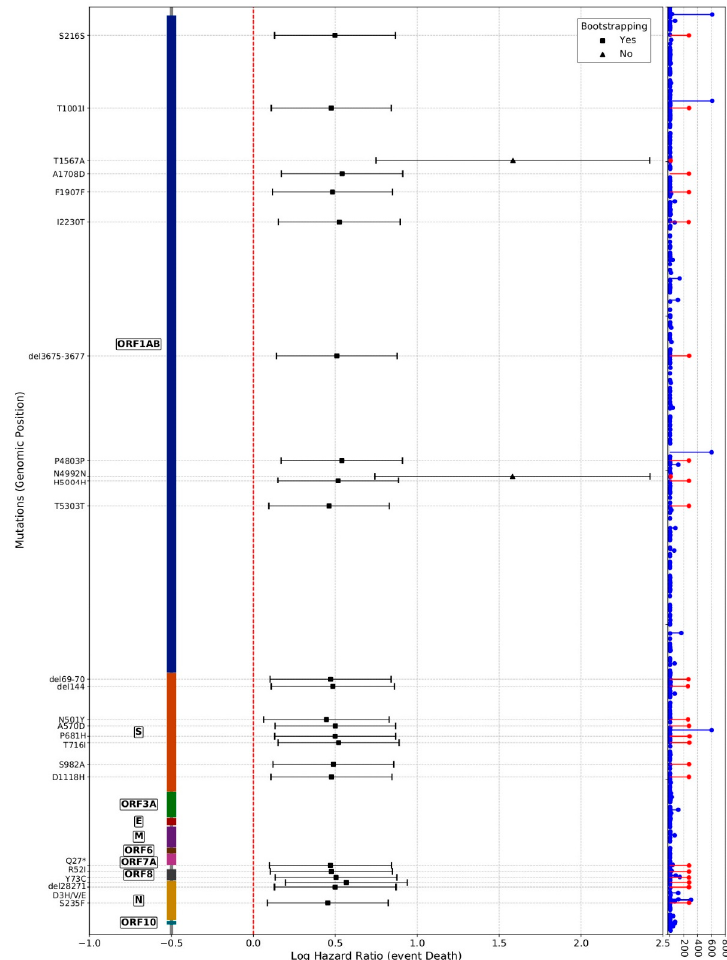
Figure 3. Log hazard ratios estimated for the 25 viral mutations that presented a significant (FDR- corrected) association with patient survival. Causal analysis was carried out using the two ap- proaches described in the text (the closed form estimator and the bootstrap). For each analysis, an estimate of the LHR along with a 95% confidence interval and a p-value (FDR-adjusted) of signifi- cance is provided. Mutations are represented over the genomic positions in which they occur and on the left part, the corresponding proteins are annotated. The right part represents the observed distribution of mutations observed in all the samples analyzed. 0.00063 substitutions per nucleotide per year (s/n/y), in agreement with the evolutionary rate previously described, which ranged from 0.0004 and 0.002 s/n/y [2,4,30,72,73]. Inter- estingly, when mutations associated with high mortality (such as ORF1ab: A1708D) are